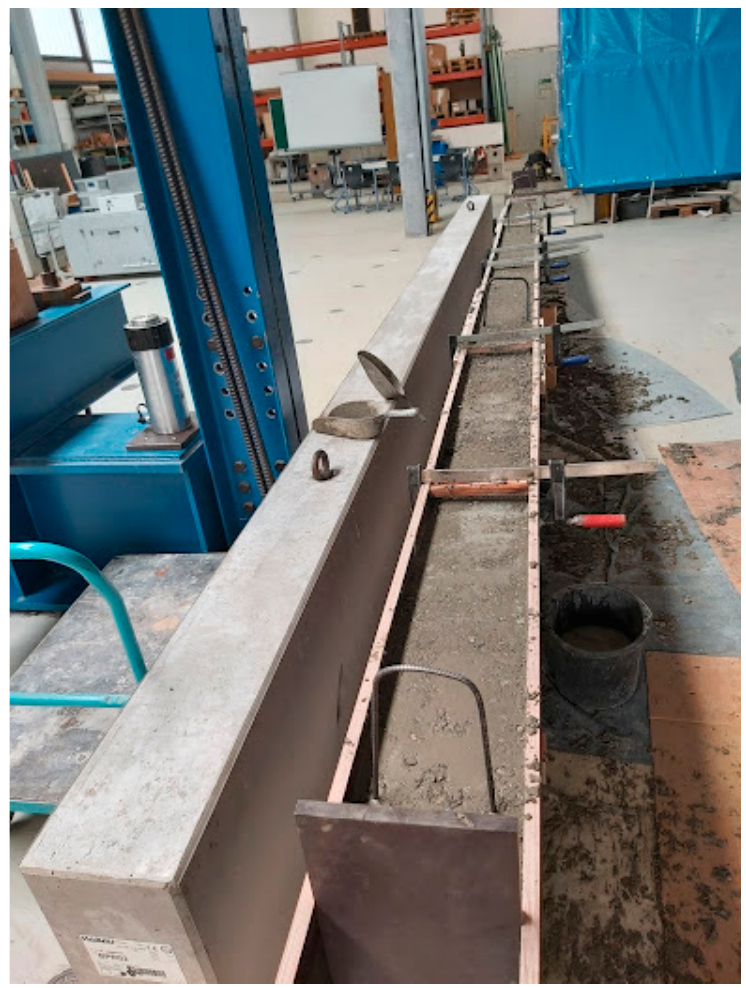
Figure 2. The SLB and TLB specimens in the university laboratory.